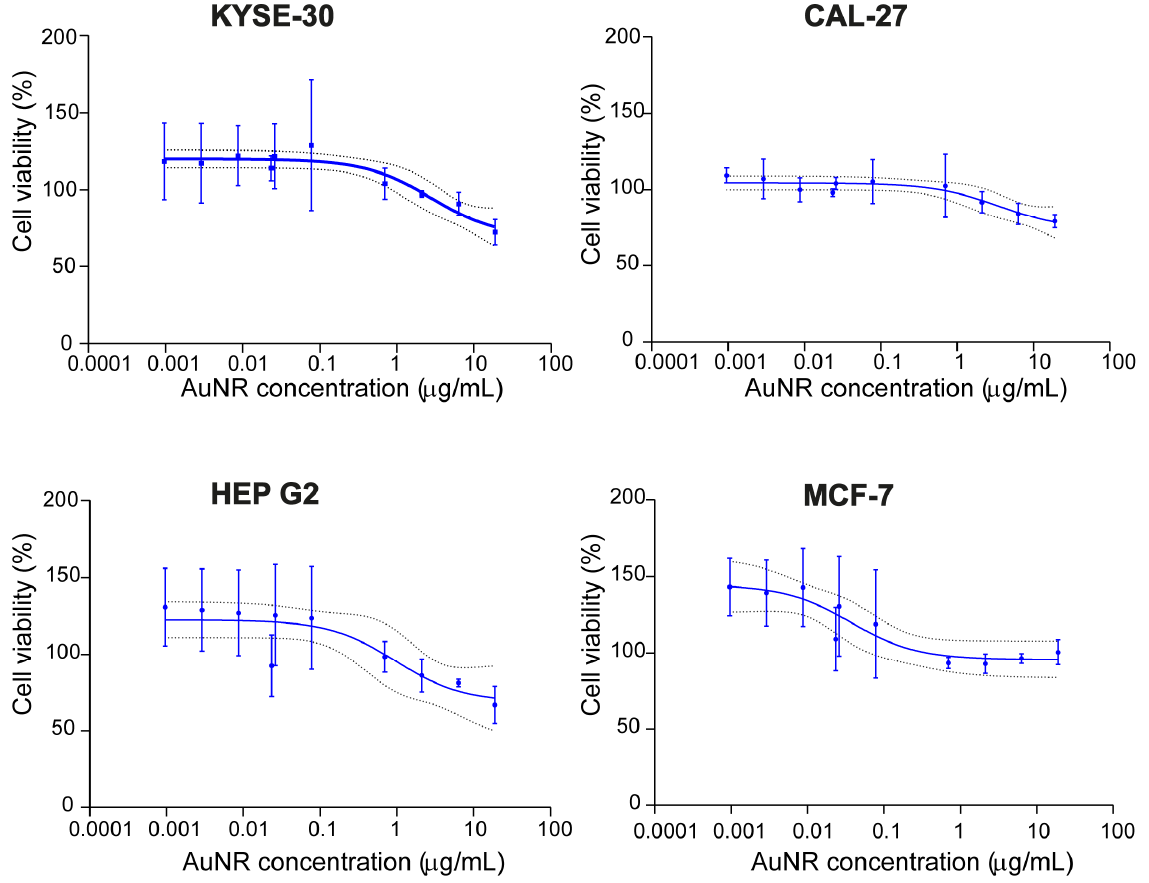
Figure 3. AuNRs had no cytotoxic effect on either EGFR-positive or EGFR-negative cancer cells. Dose-response curves for different cancer cell lines, n = 3, the dotted lines represent 95% CI.